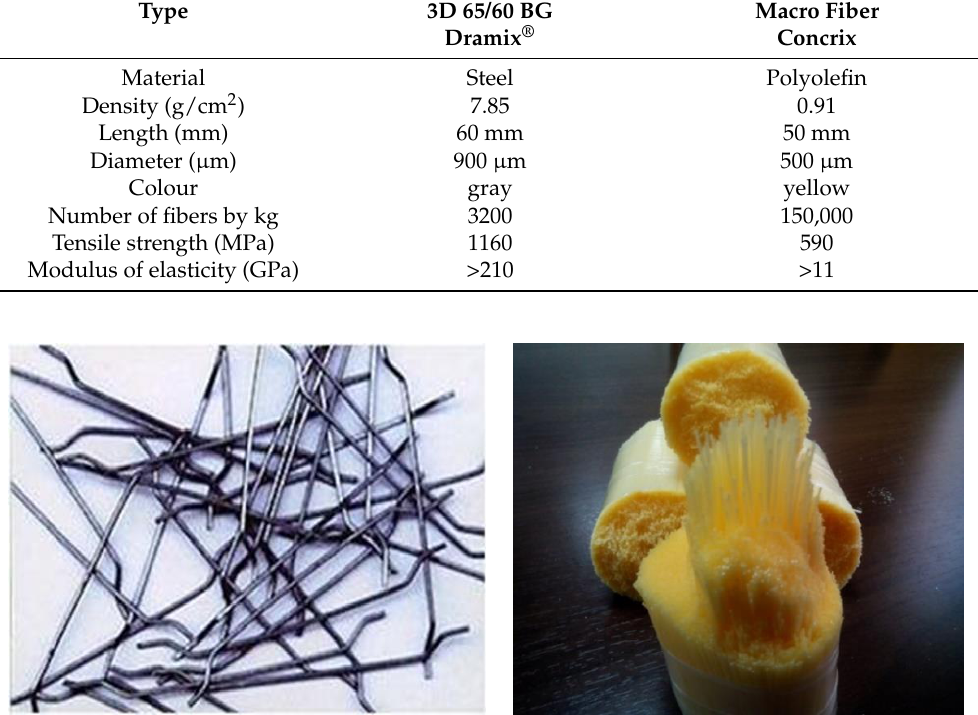
Figure 2. ( left ) Steel fiber and ( right ) Synthetic (polypropylene) fiber.